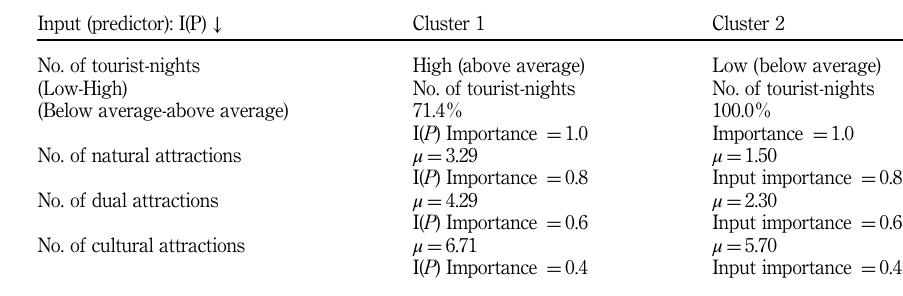
Table IV. Relative importance of input